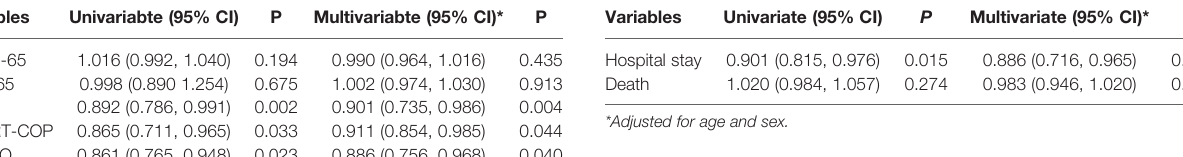
TABLE 4 | Association between serum IL-37 and the prognosis among CAP patients.